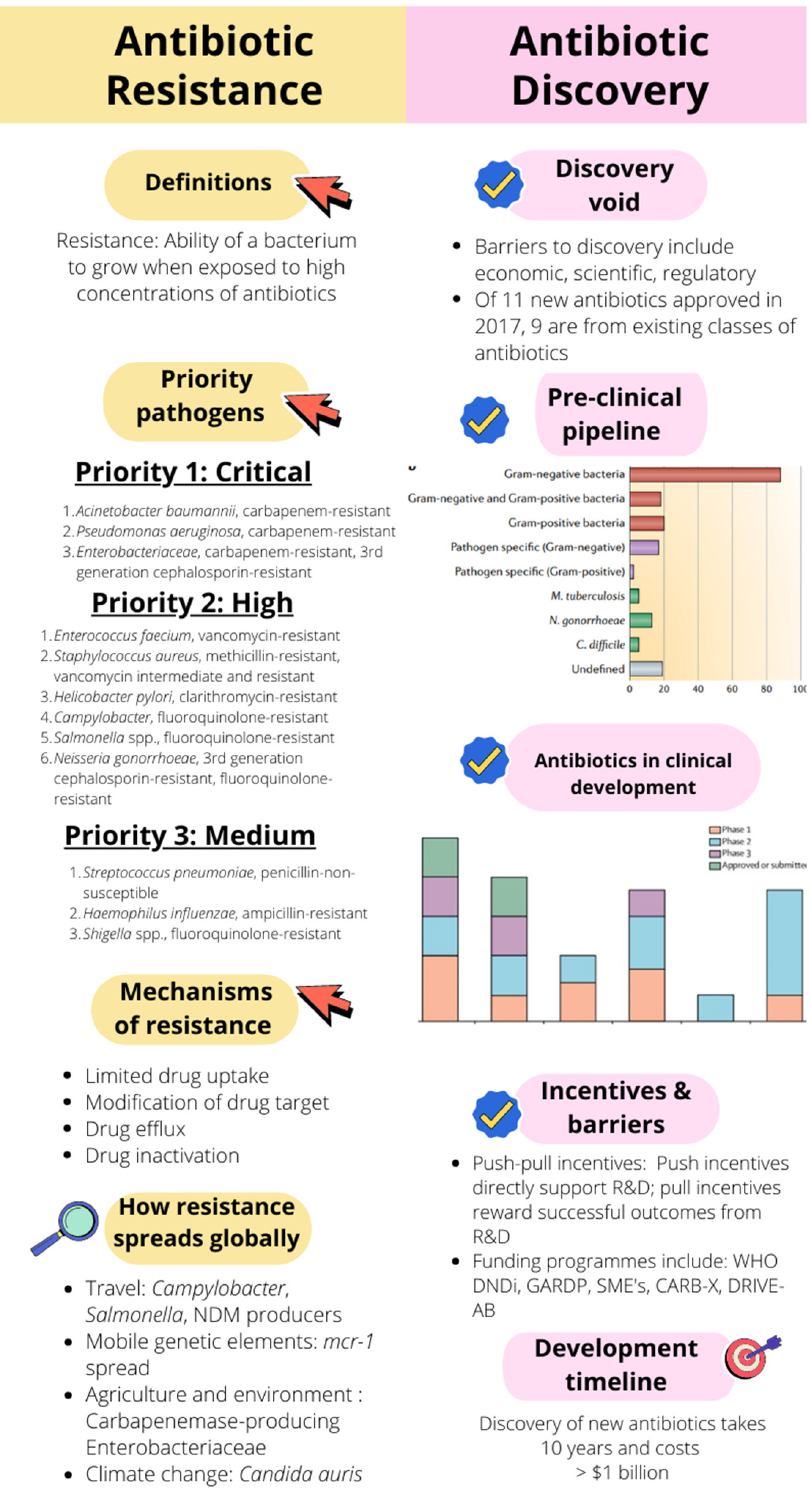
Figure 2. The basic concepts of antibiotic resistance (the chase) and antibiotic discovery (the race) discussed in this article. Pre-clinical pipeline graph: [13]. Antibiotics in clinical development: [14]. WHO DNDi: Health Organization Drugs for Neglected Diseases Initiative; GARDP: Global Antibiotic Research and Development Partnership; SMEs: Small and Medium-Sized Enterprises; CARB-X: Combating Antibiotic-Resistant Bacteria Biopharmaceutical Accelerator; DRIVE-AB: Driving reinvestment in research and development for antibiotics and advocating their responsible use.